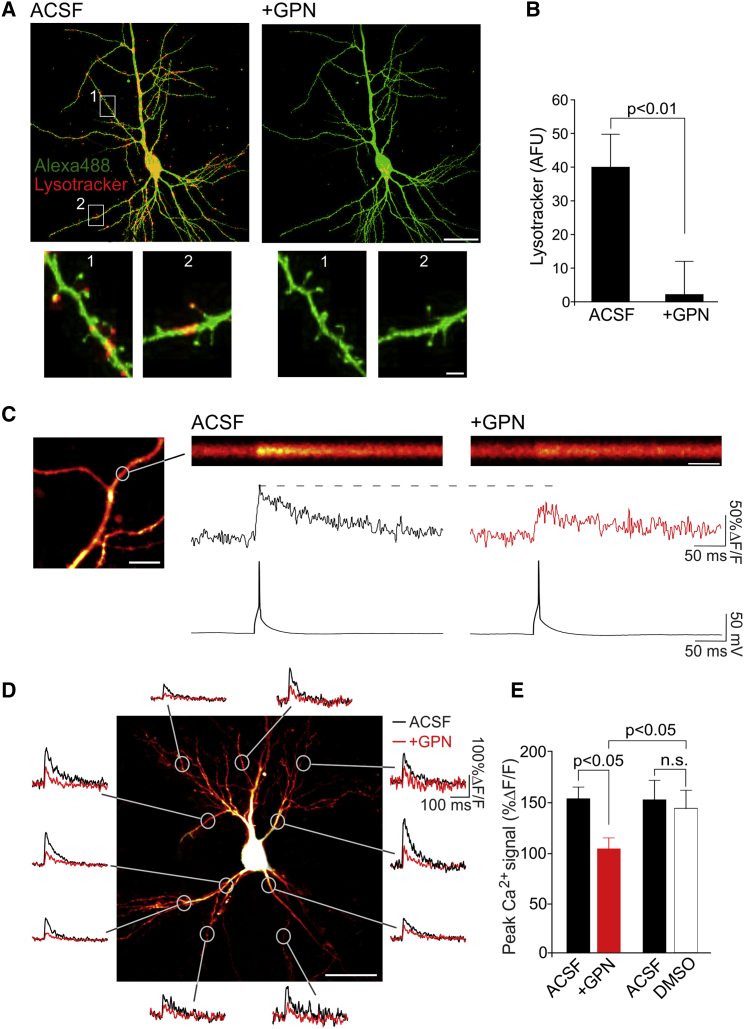
Lysosomes Contribute to bpAP-Evoked Dendritic Ca2+ Signaling(A) Top: CA1 neuron loaded with Alexa 488 (green) and stained with LysoTracker (red) (scale bar, 10 μm). Disruption of the lysosomal membrane with GPN abolished LysoTracker staining. Regions of interest (white boxes) are magnified below (scale bar, 2 μm).(B) Average LysoTracker staining in ACSF (artificial cerebrospinal fluid) and GPN (n = 5 cells/condition). Significance was assessed with a Mann-Whitney test.(C) Example bpAP-evoked Ca2+ transient in CA1 apical dendrites loaded with OGB-1 (scale bar, 10 μm). Laser scanning was restricted to a line across a region of interest (circle). The resulting line scan (scale bar, 50 ms), along with its quantification (%ΔF/F) is shown time-locked with electrophysiological recordings. GPN reduced the bpAP-evoked Ca2+ influx.(D) CA1 neuron loaded with OGB-1. Ca2+ transients evoked before (black traces) and after (red traces) the addition of GPN are shown for regions of interest (scale bar, 20 μm).(E) Average data (n = 7–18 cells/condition).Significance was assessed with Kruskal-Wallis and post hoc Dunn’s tests. Error bars represent SEM. See also Figures S1 and S2.